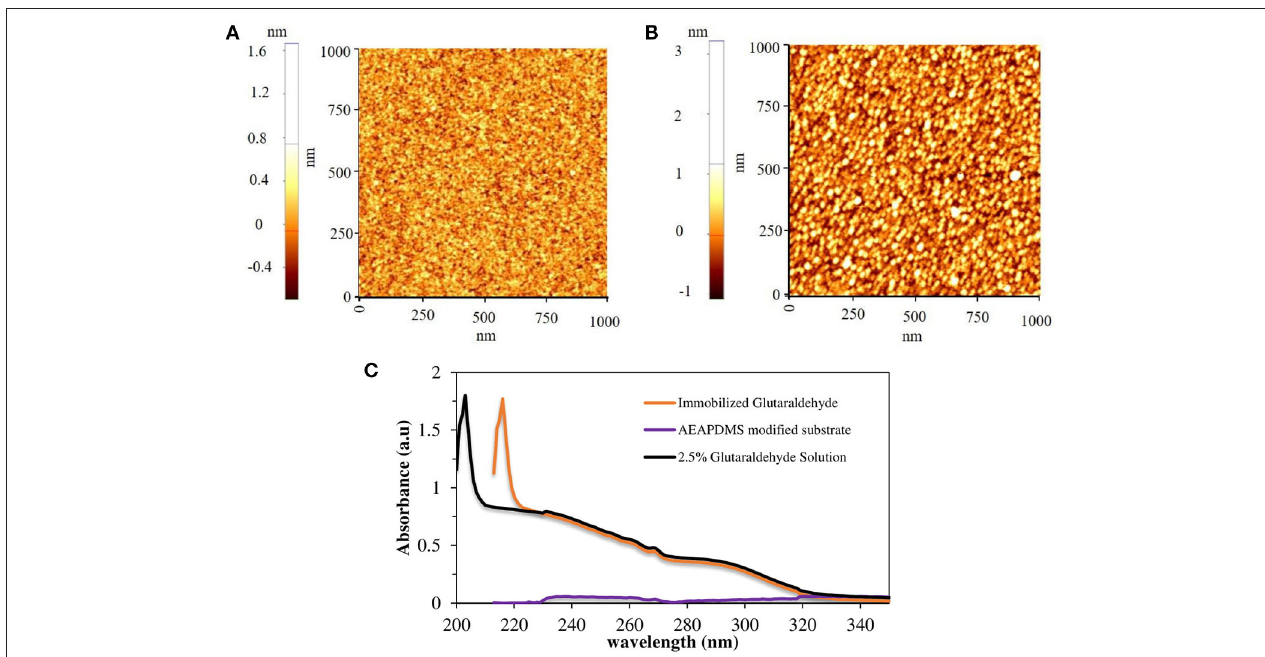
FIGURE 1 | AFM images of (A) AEAPDMS modified substrate and (B) glutaraldehyde modified substrate, (C) UV-Vis spectra of glutaraldehyde solutions and glutaraldehyde modified quartz substrate.